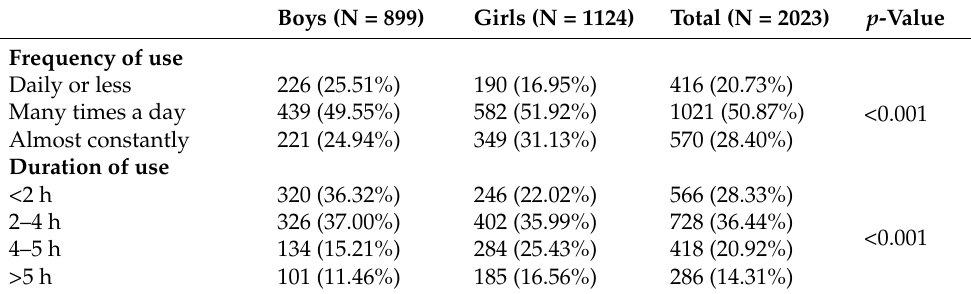
Table 2. Frequency and duration of social media use across gender. The p -values refer to differences between boys and